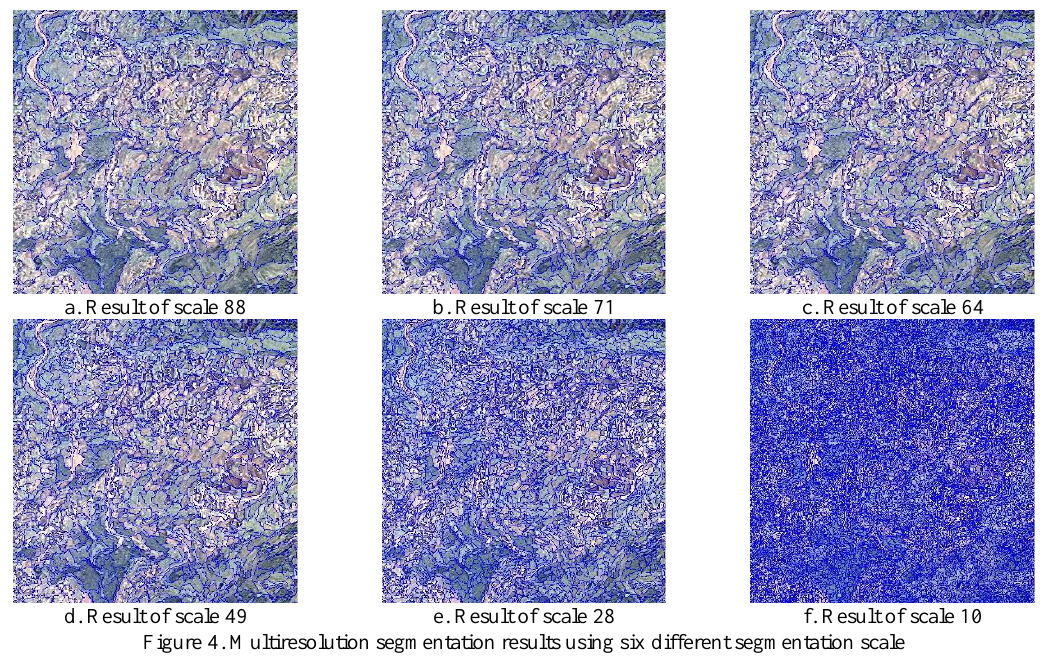
Figure 4. Multiresolution segmentation results using six different segmentation scale